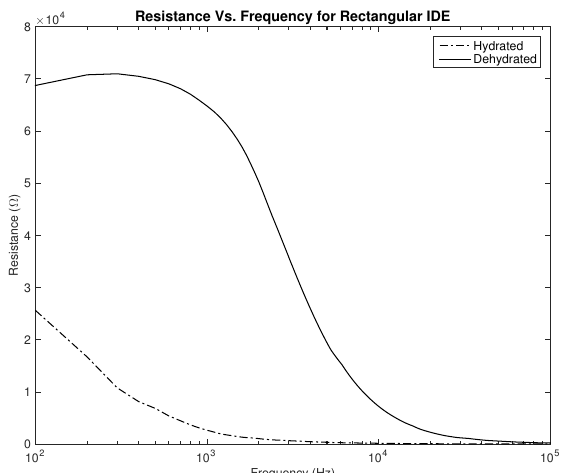
Figure 6. Simulation results—resistance ( Ω ) of hydrated and dehydrated skin using the rectangular IDE